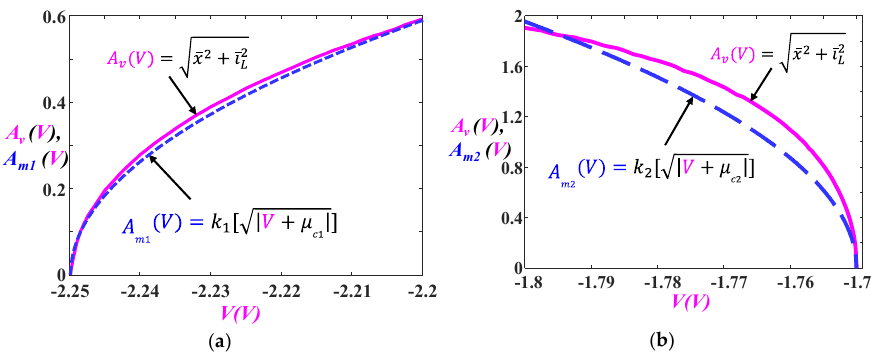
Figure 6. Numerical verification of supercritical Hopf bifurcation of the 6-lobe CCM oscillator circuit. Verification of supercritical Hopf bifurcation as a parameter μ = V near ( a ) first Hopf bifurcation point